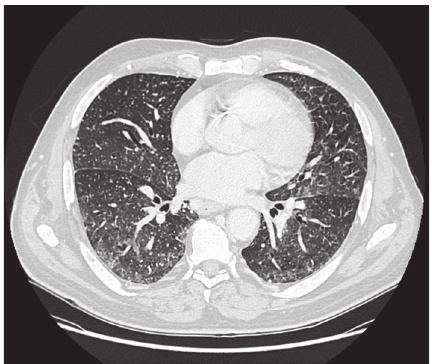
Figure 1: CT chest showing miliary nodules scattered throughout both lungs.